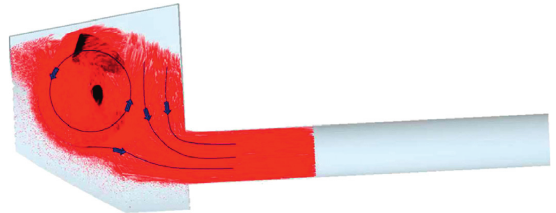
Figure 16: The flow trajectory of concrete. Particles near the stirring blade on the suction side.